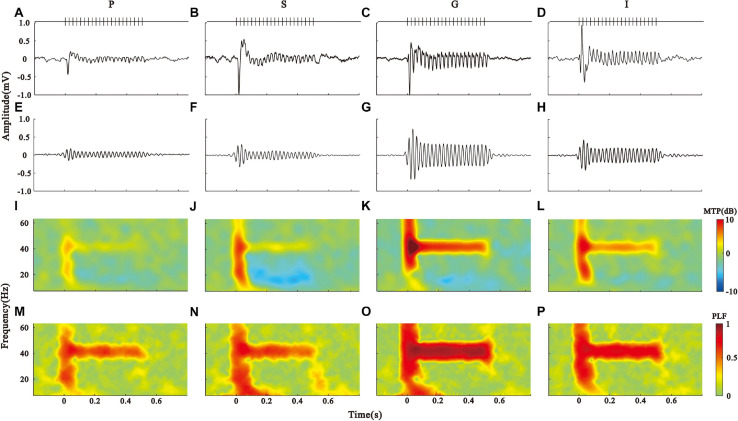
Layer-specific ASSR patterns in the AC. (A–D) Click-train evoked LFPs averaged across the pia (P), supragranular (S), granular (G), and infragranular (I) layers, respectively. (E–H) 35–45 Hz filtered LFPs. (I–L) spectral-temporal function of MTP in the P, S, G, and I layers. (M–P) spectral-temporal function of PLF in the P, S, G, and I layers.